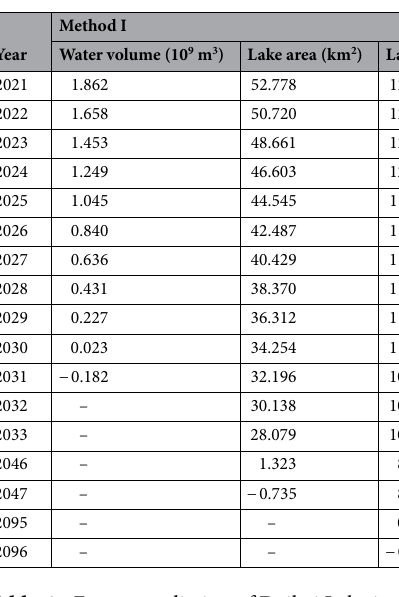
Table 6. Future prediction of Daihai Lake in situation